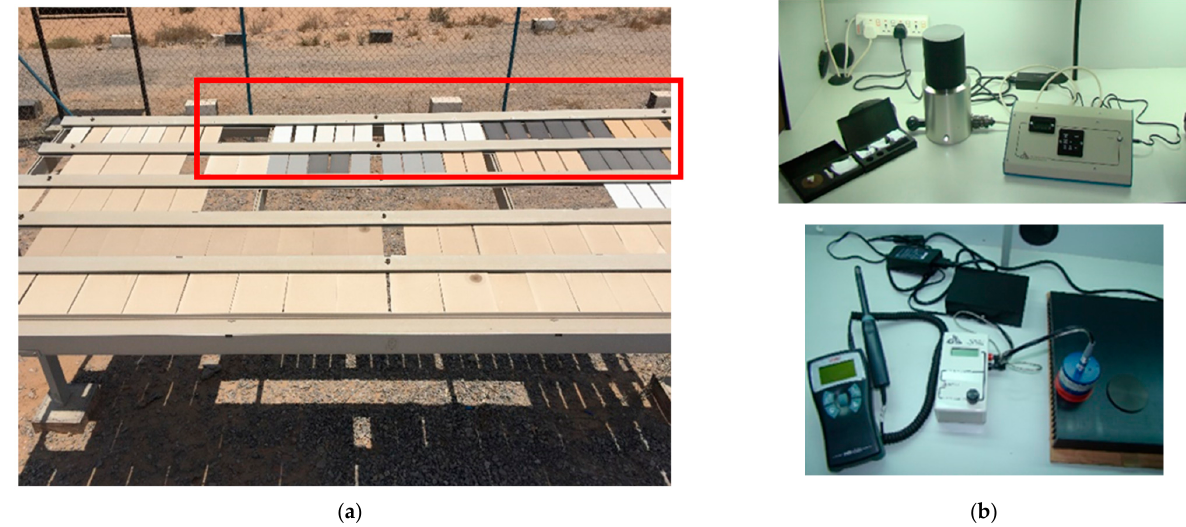
Figure 2. ( a ) Triplicate samples of the roof and wall paints exposed at weathering farm on a 5o tilt rack (red box) and ( b ) Equipment used for SRI evaluation, Solar reflectometer (top), emissometer (bottom)